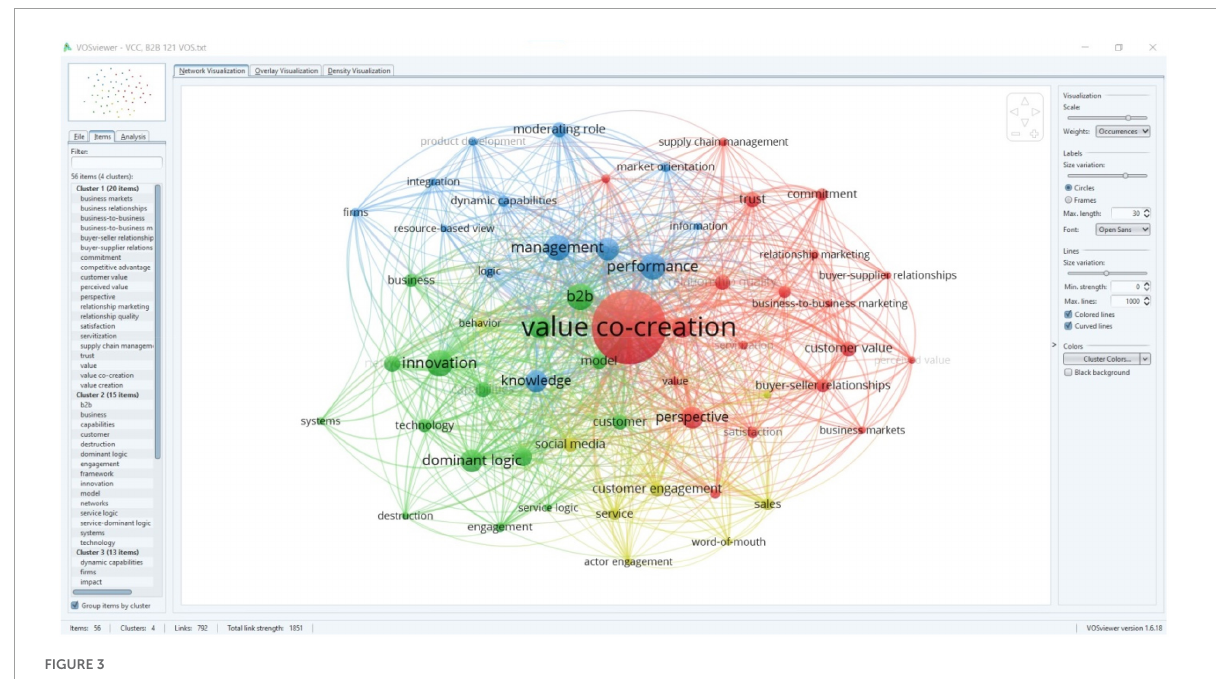
FIGURE3 Cartography analysis using VOS